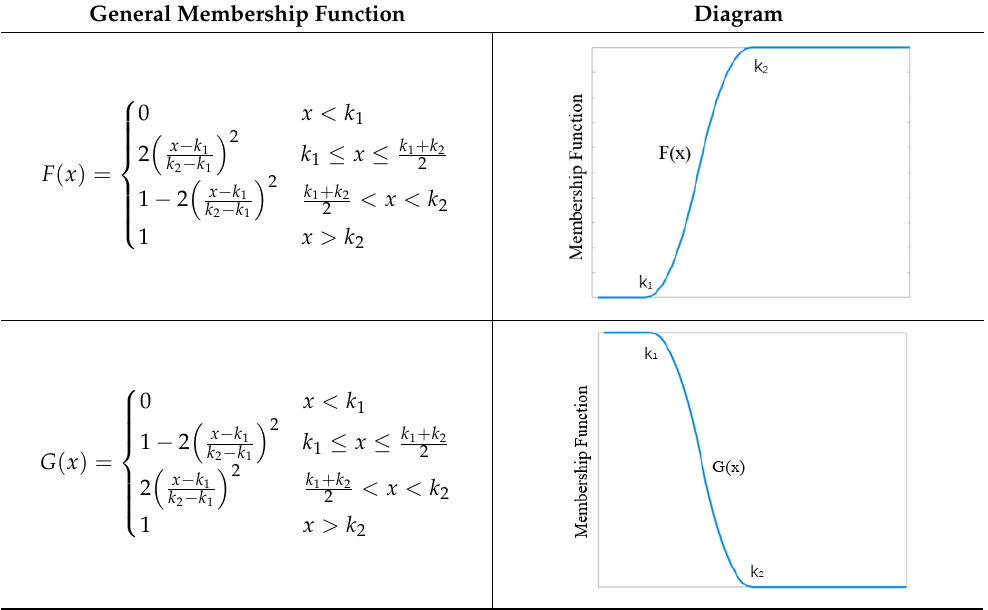
Table 4. The relationship between the fuzzy sets and situations.